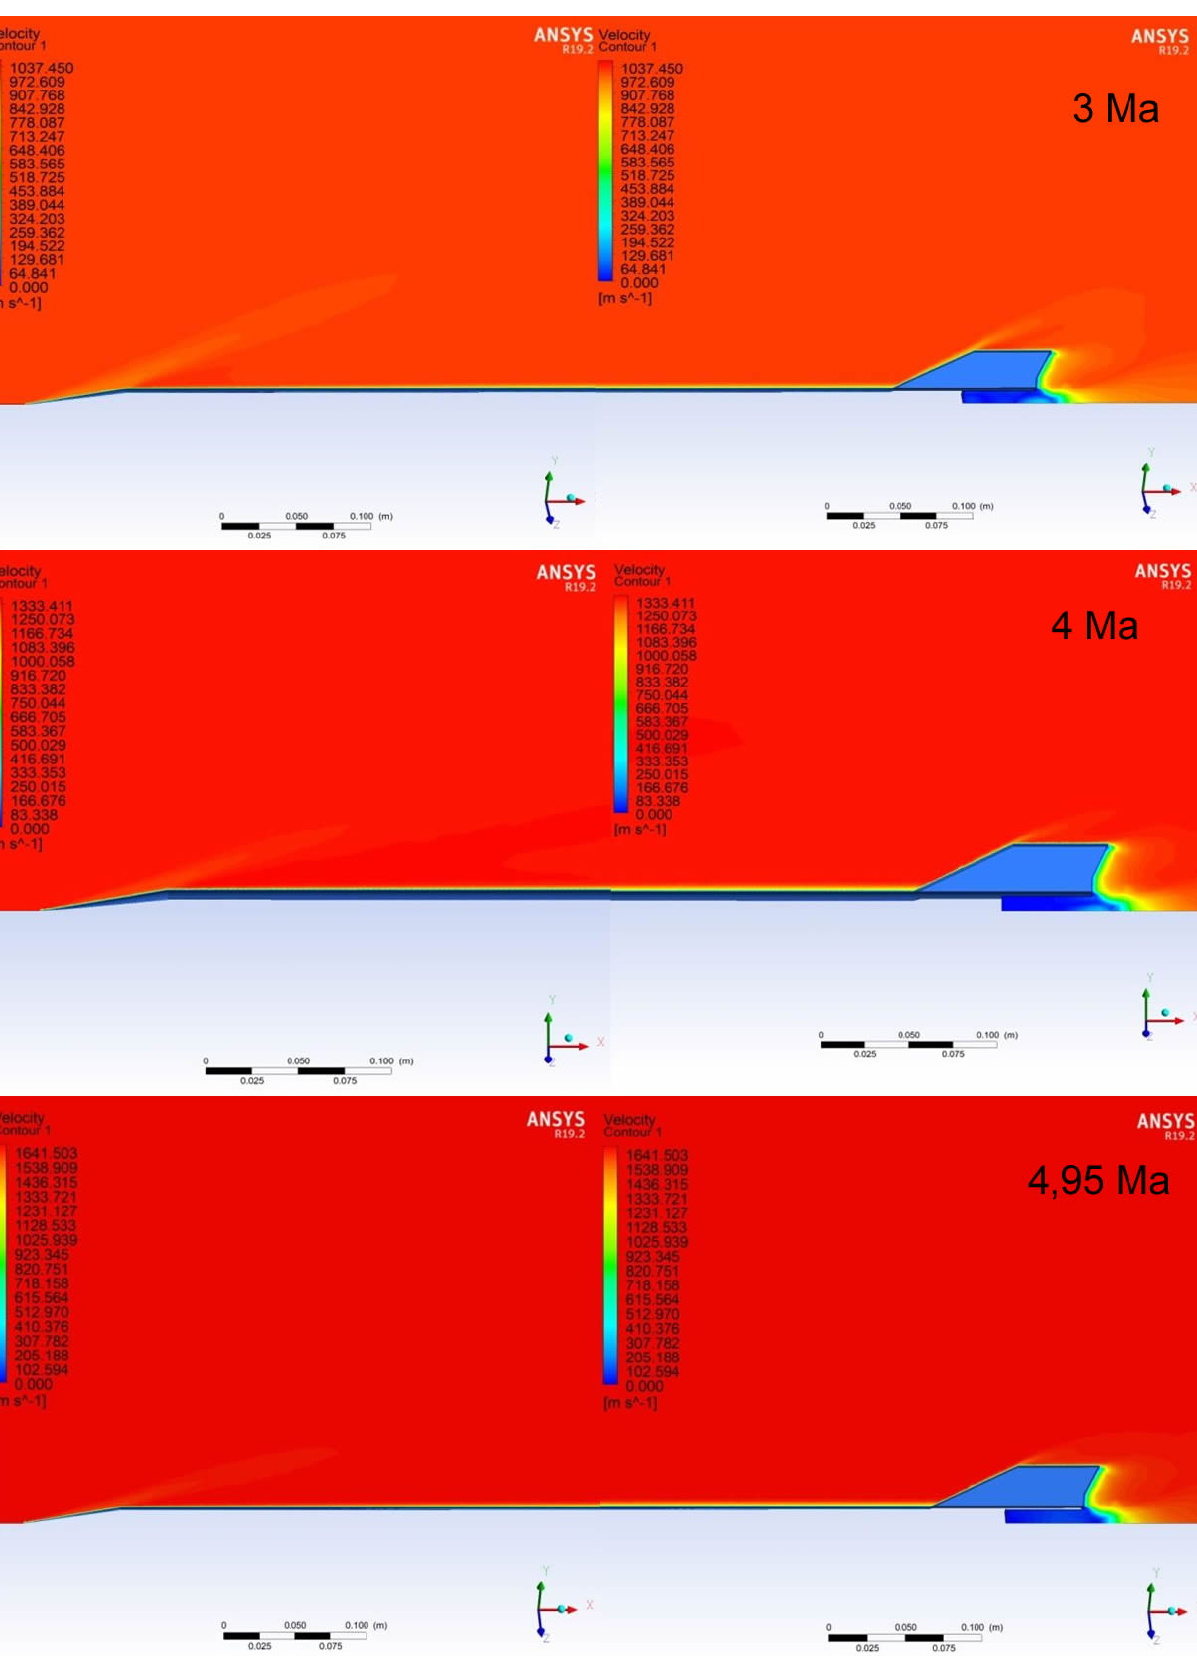
Figure 21. Field of velocities around the projectile 120 mm, M829A2 for different Mach numbers